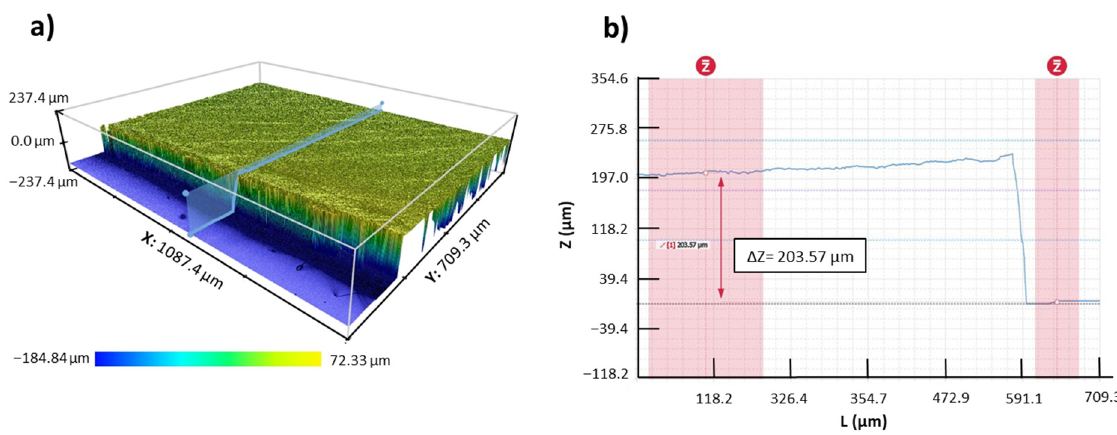
Figure 8. ( a ) 3D confocal image of the cross-section S3 sample, where a restore algorithm and a vertical profile have been selected. ( b ) 2D image of the vertical profile with the step function measurement.